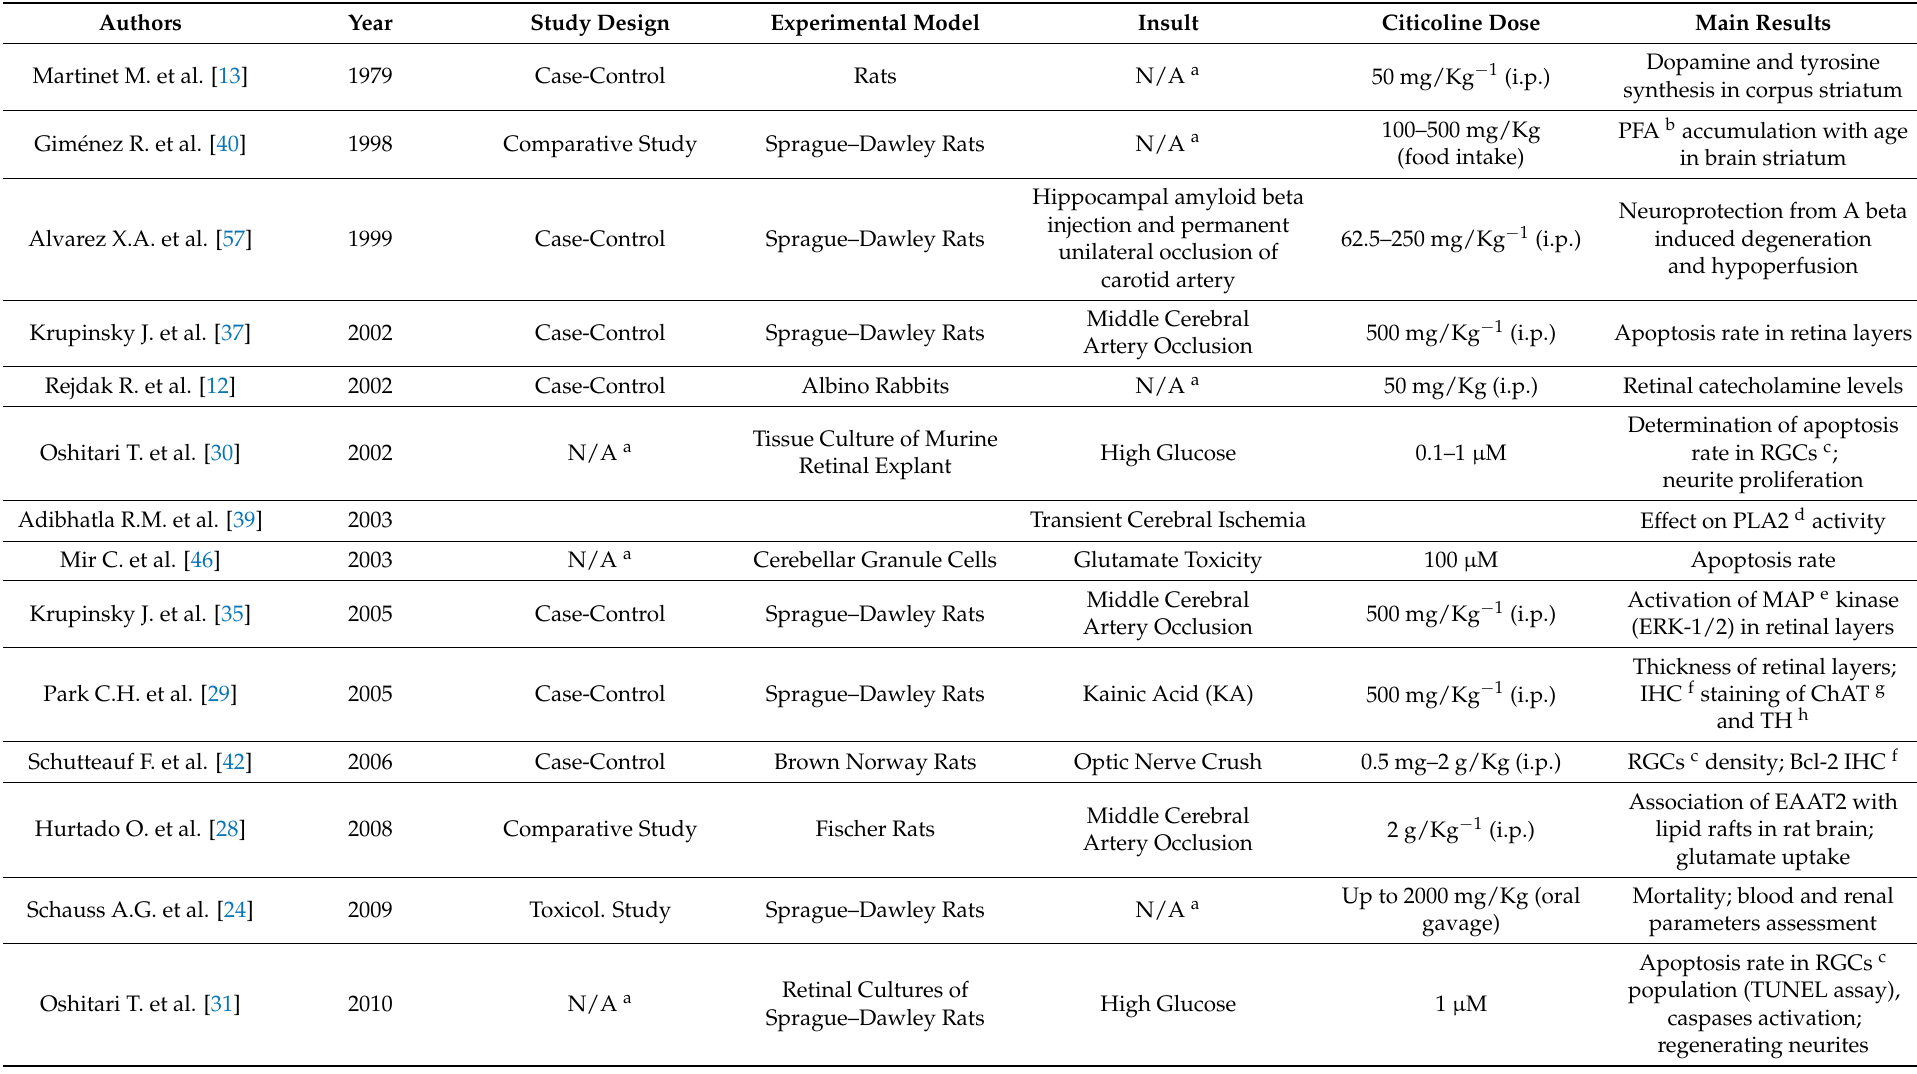
Table 1. Summary of pre-clinical studies evaluating the therapeutic efficacy and the mechanism of action of Citicoline in vitro and in